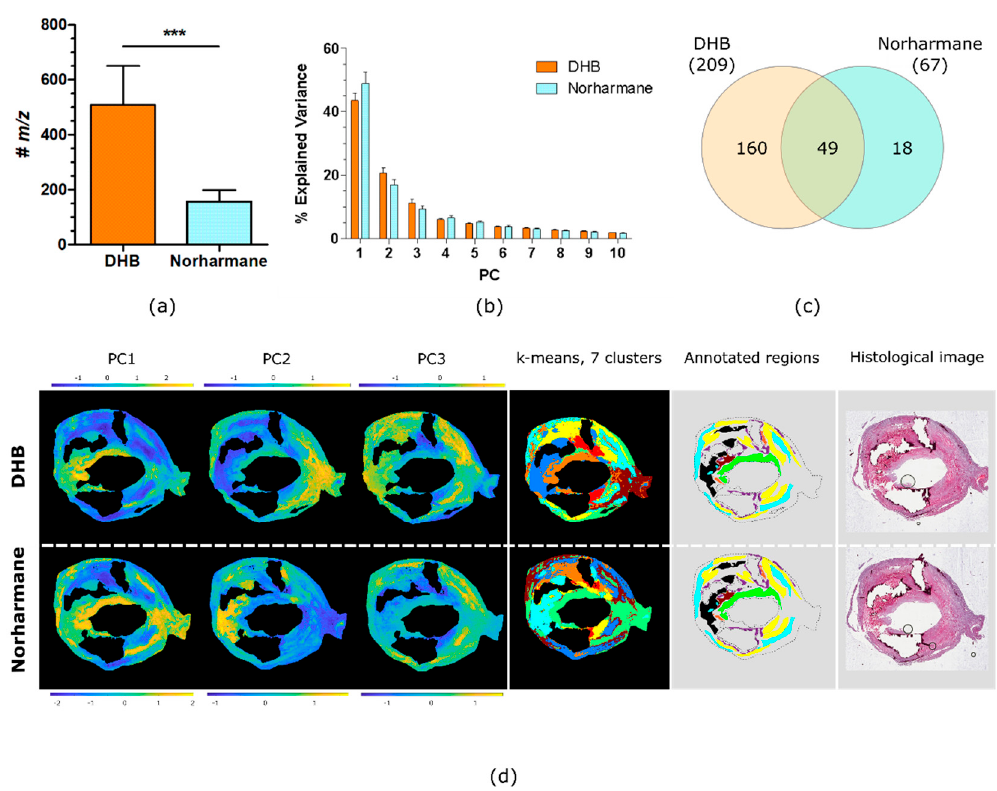
Figure 3. Comparison of DHB and norharmane matrices. ( a ) Number of lipid ions detected in all MSI datasets from all patients, for MSI datasets acquired using DHB and norharmane matrices (mean ± SD, two-tail paired t-test, ***: p < 0.001, n = 6). ( b ) Explained variance of the first ten PCs (mean ± SD, n = 6). ( c ) Venn diagram of the lipid ions in common between all MSI datasets acquired with DHB and norharmane. ( d ) Score images of the first 3 PCs, k-means clustering (7 clusters), annotated regions and histological images for the same carotid plaque. Annotated regions are calcification (purple), hemorrhage (brown), lipid-necrotic core (black), collagen (yellow), macrophages (orange), outer VSMCs (cyan) and inner VSMCs (green).